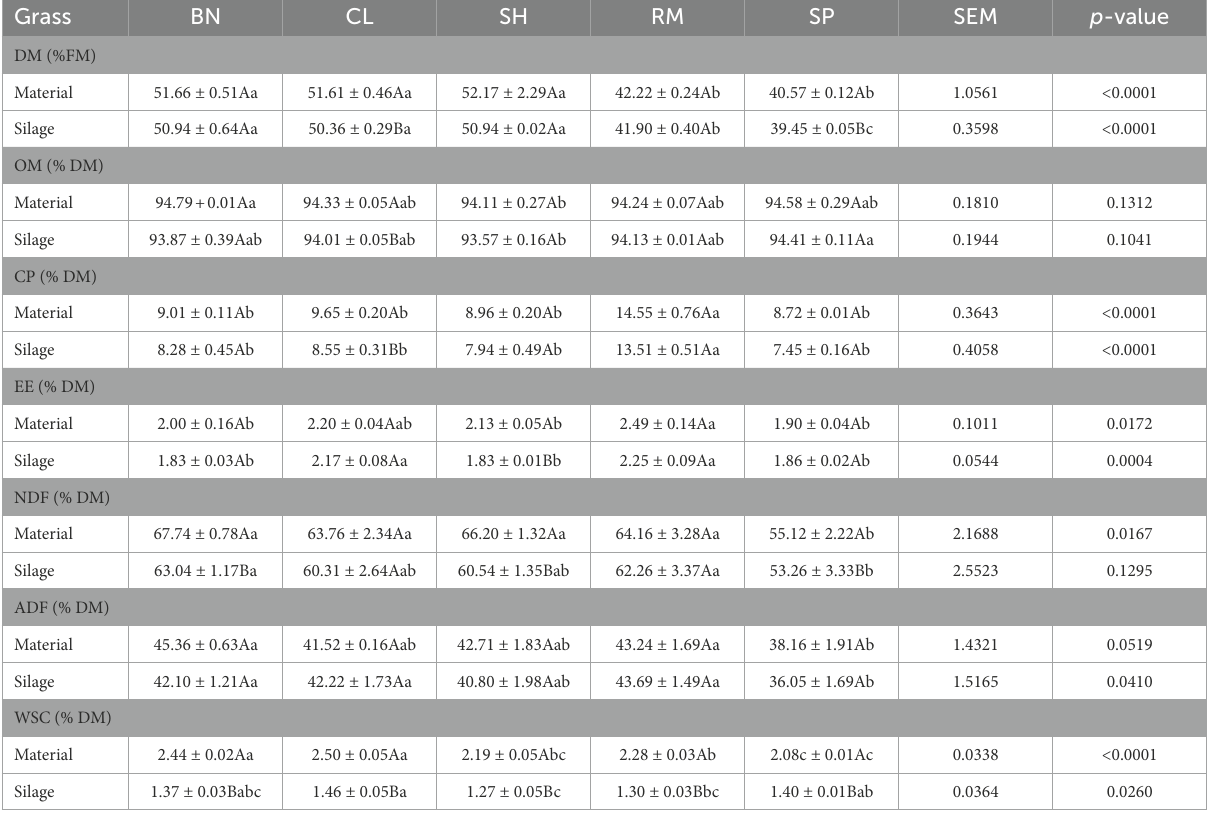
TABLE 3 Chemical composition of native grasses. Grass